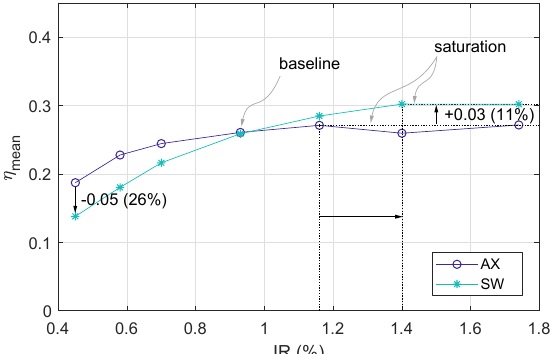
Figure 12. Area averaged film cooling effectiveness η for axial inflow AX (blue ◦ ) and swirling inflow SW (green ∗